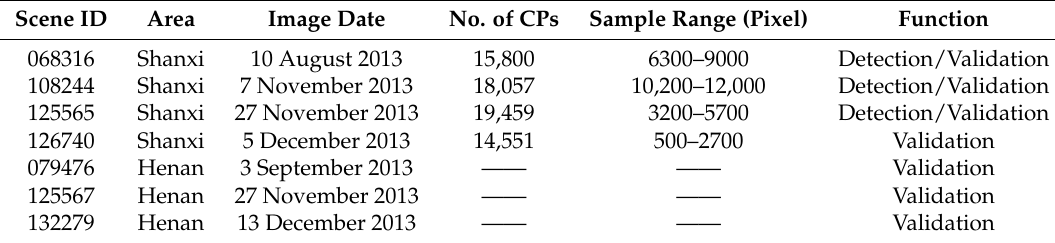
Table 3. GF-1 WFV-1 images used in method validation.